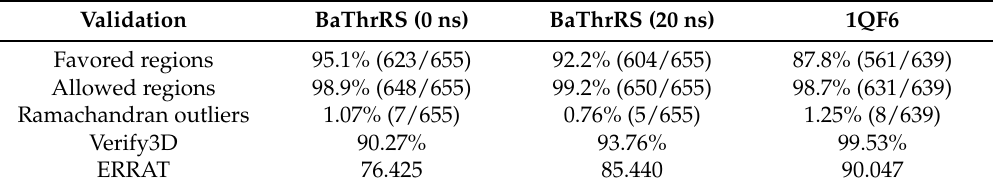
Table 1. Validation of various 3D structures.